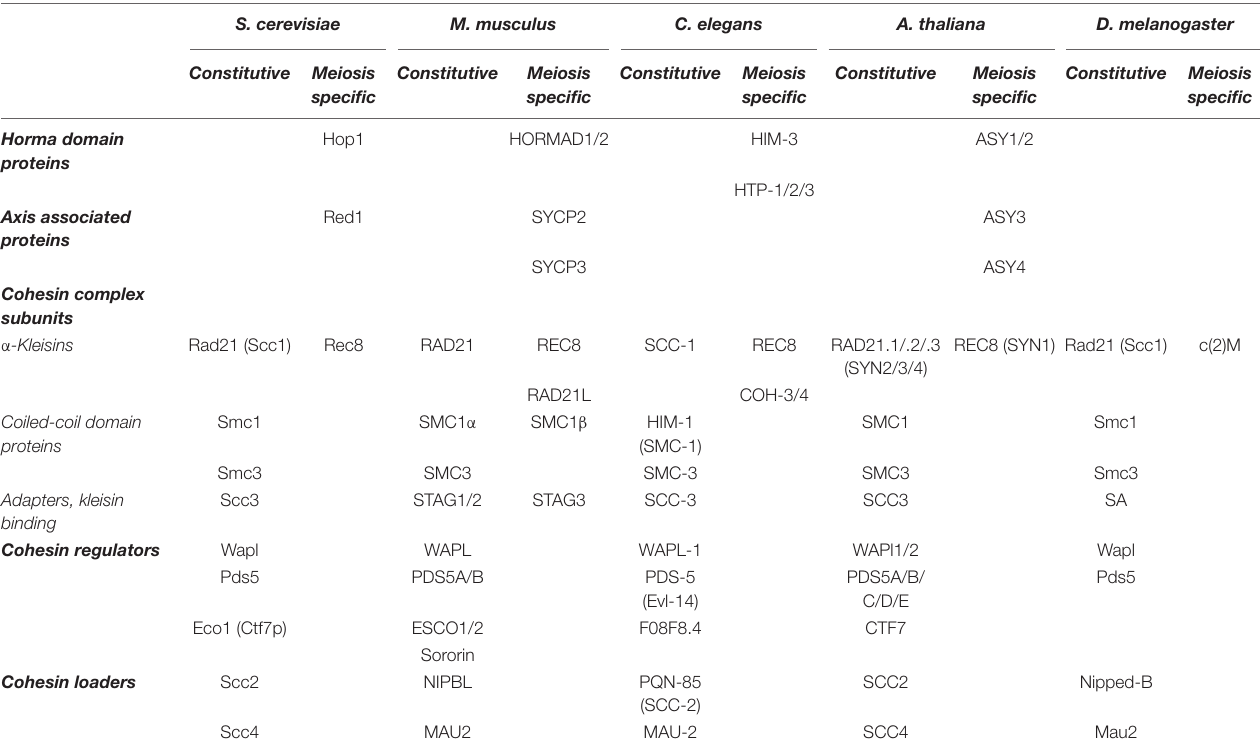
TABLE 1 | Evolutionary conservation of axis